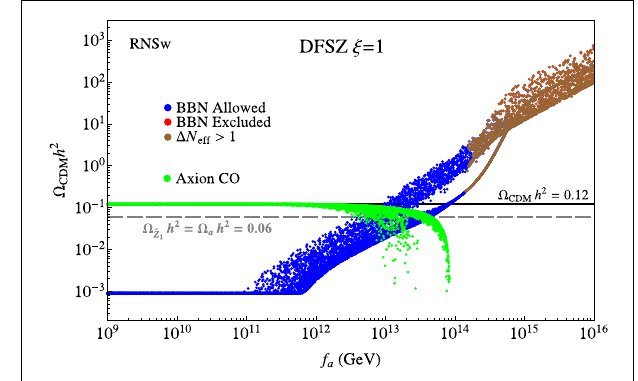
FIGURE 8 | The wino-like WIMP and axion relic densities from a scan over SUSY DFSZ parameter space for the RNSw benchmark case with ξ = 0 . The gray dashed line shows the points where DM consists of 50% axions and 50% neutralinos.